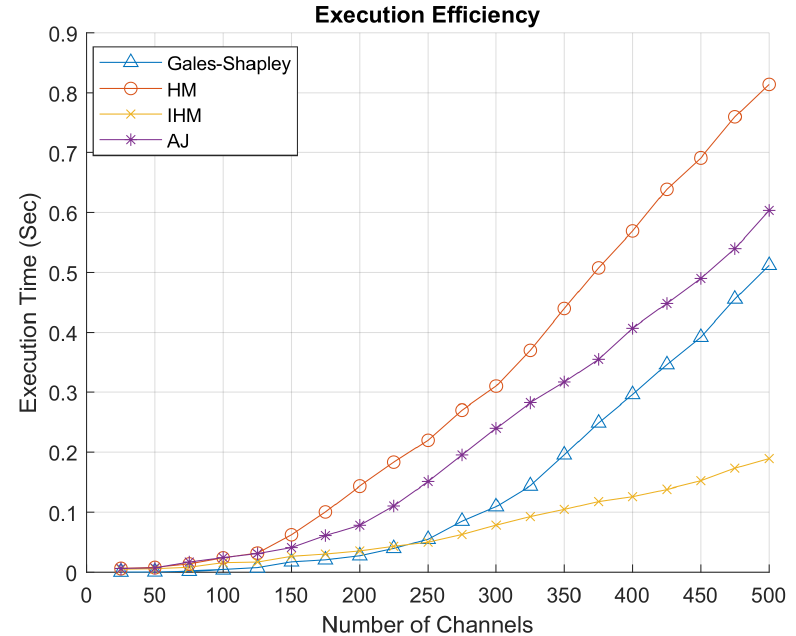
Figure 10. Execution